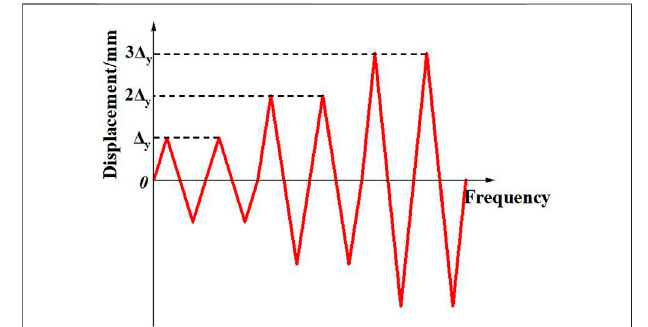
FIGURE 4 | Loading system of horizontal cyclic load.